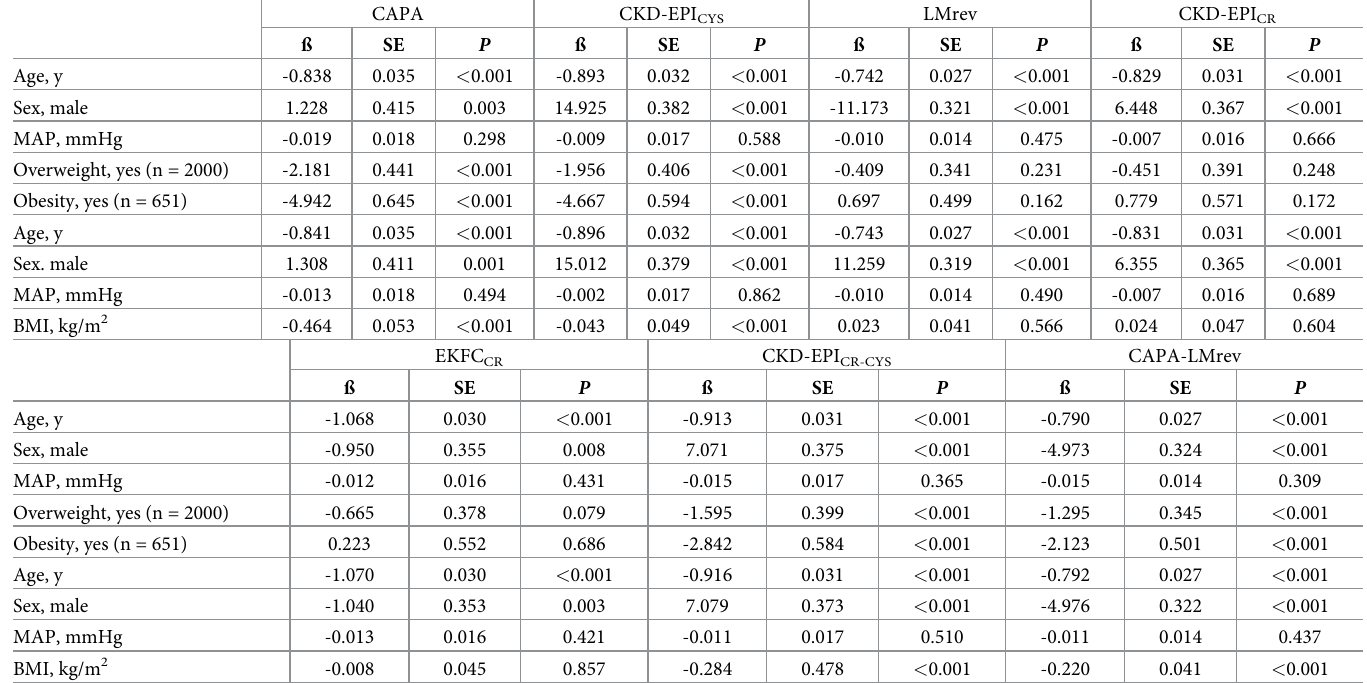
Table 3. Association between body mass index and eGFR